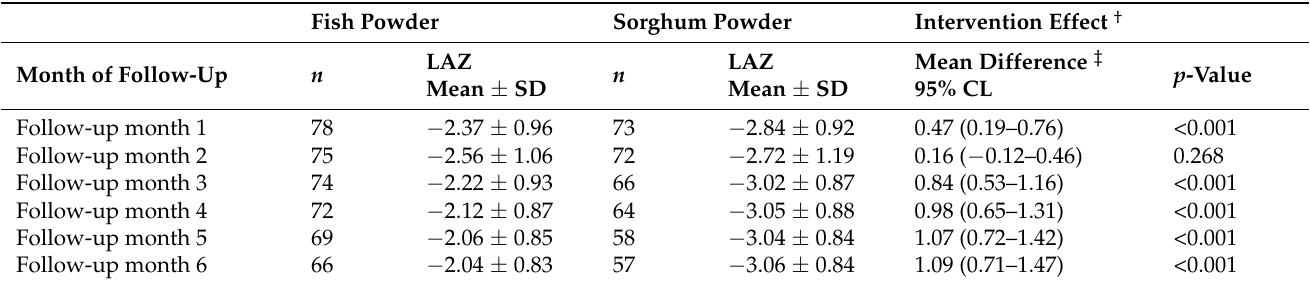
Table 7. The intervention effect of the fish powder on LAZ at each month of follow-up as assessed using liner mixed effect sensitivity analysis.